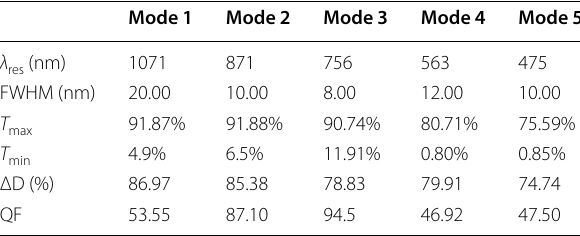
, FWHM, transmittance peaks ( T res